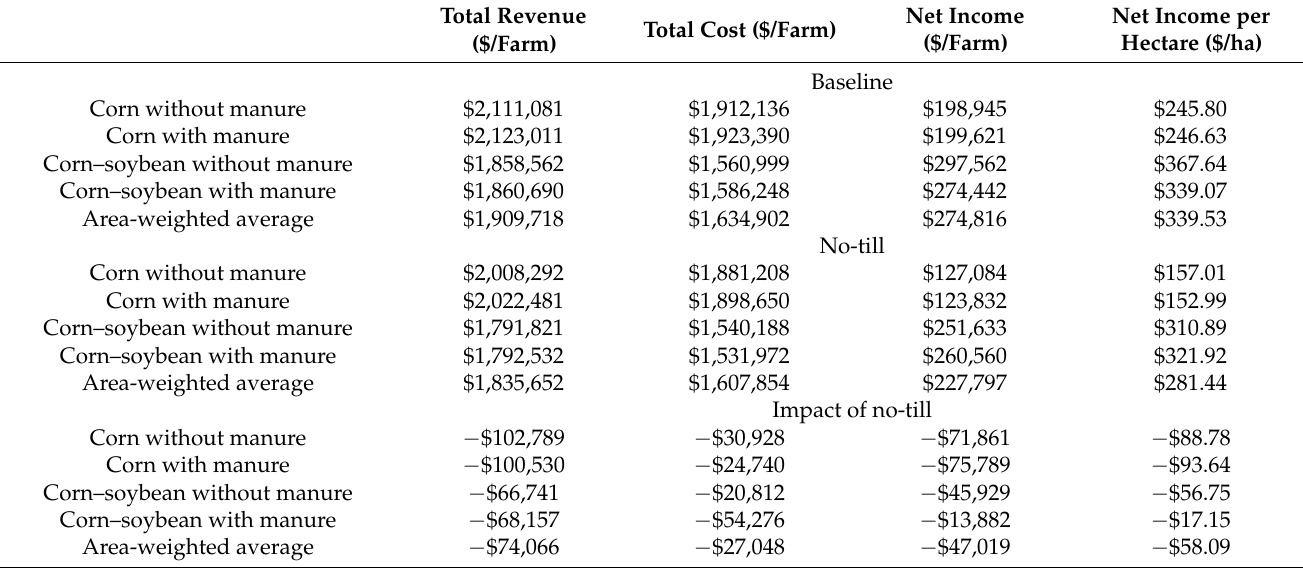
Table 9. Average annual conservation tillage impacts on farm-level economics